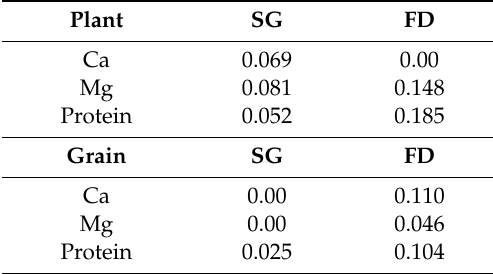
Table 5. Jaccard index for similarity between bands selected by partial least square regression (PLS) for the US and Ethiopia (ET) datasets for the various